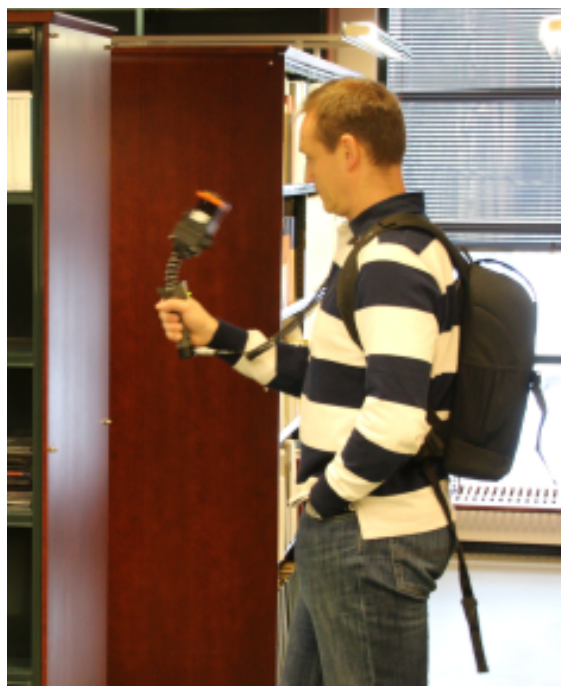
Figure 5. Data acquisition using